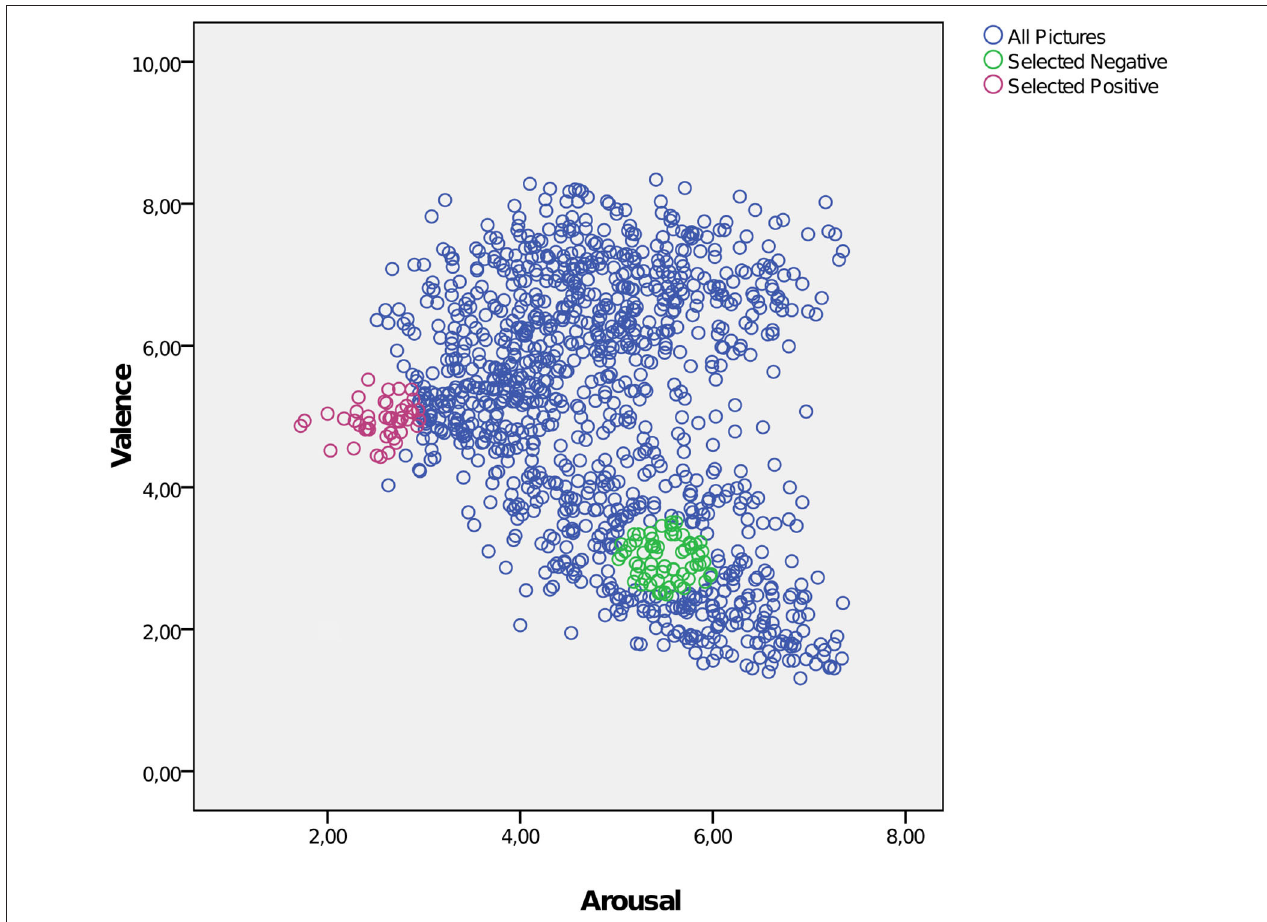
FIGURE 1 | Selection of negative and neutral IAPS images intended to achieve a high uniformity with regard to the factors “valence” and “arousal.” Blue circles: all IAPS images; green circles: selected negative images; red circles: selected neutral images. X-axis: arousal; y-axis: valence (1 = very negative, 9 = very positive).